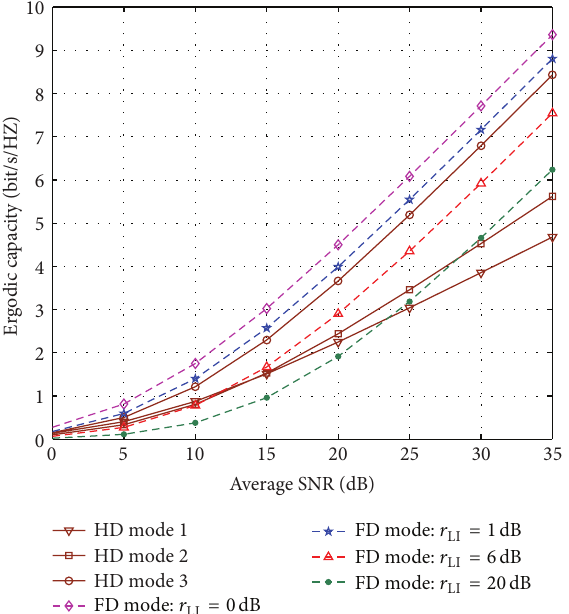
Figure 5: Ergodic capacity of FD mode with different loop inter- ference, comparing with HD mode when average SNR 𝑟 For the baselines of HD modes, HD mode 1 represents 4-time-slot scheme, HD mode 2 represents 3-time-slot scheme, and HD mode 3 represents 2-time-slot scheme